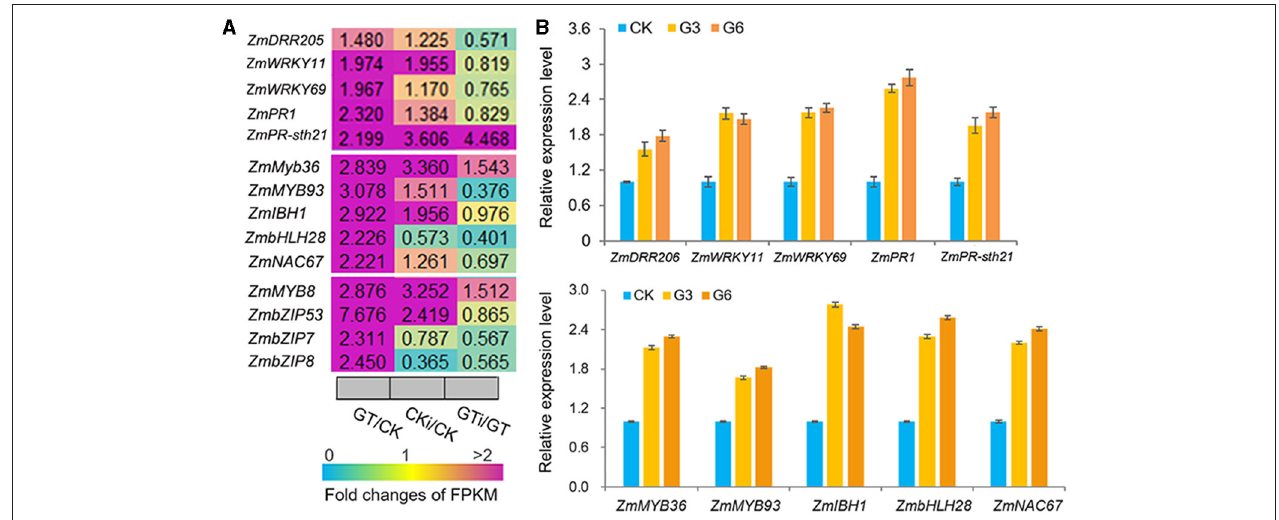
FIGURE 7 | ZmGT-3b knockdown significantly upregulates the different transcription factor (TF) genes that are involved in the plant defense response to various biotic/abiotic stresses. (A) Relative expression levels (fold) of TF genes, including myeloblastosis (MYBs), basic leucine zipper (bZIPs), NAM, ATAF, and CUC (NACs), basic helix-loop-helixes (bHLHs) genes, and two PR genes, as revealed by the transcriptome sequencing of ZmGT-3b knockdown (GT) and CK (LH244, wild type) maize seedlings with (CKi and GTi) or without inoculation (CK and GT). (B) Defense-related genes such as ZmDRR206 , ZmPR1 , and ZmPR-STH21 and multiple defense-related TF genes such as ZmWRKY11 , ZmWRKY69 , ZmMYB36 , ZmMYB93 , ZmIBH1, ZmbHLH28 , and ZmNAC67 were upregulated in GT-KD seedlings, as confirmed by qRT-PCR. Values are the mean ± SD ( n = 3). CK represents CK seedlings (LH244), and G3 and G6 represent the seedlings from the different transgenic events with the knocked-down expression of ZmGT-3b . These experiments were repeated with three different biological repeats and each with three technical repeats. All seedlings were grown under normal conditions and sampled at 7